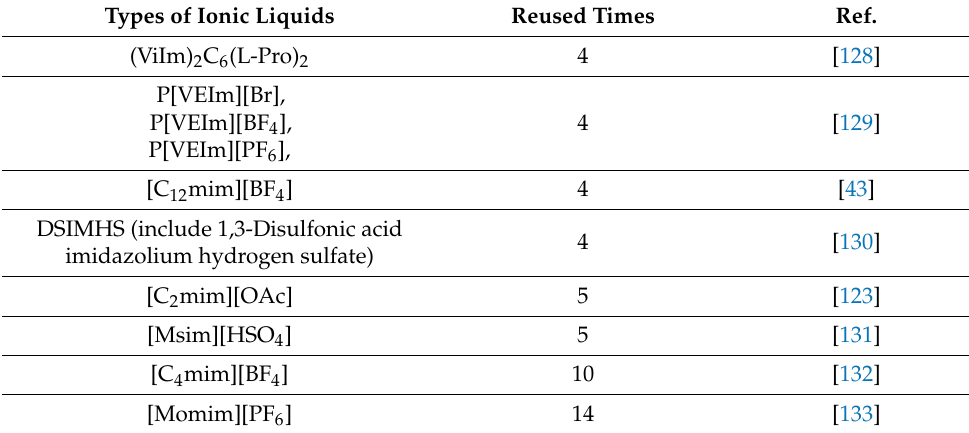
Table 4. Recycle and reuse of imidazolium ionic